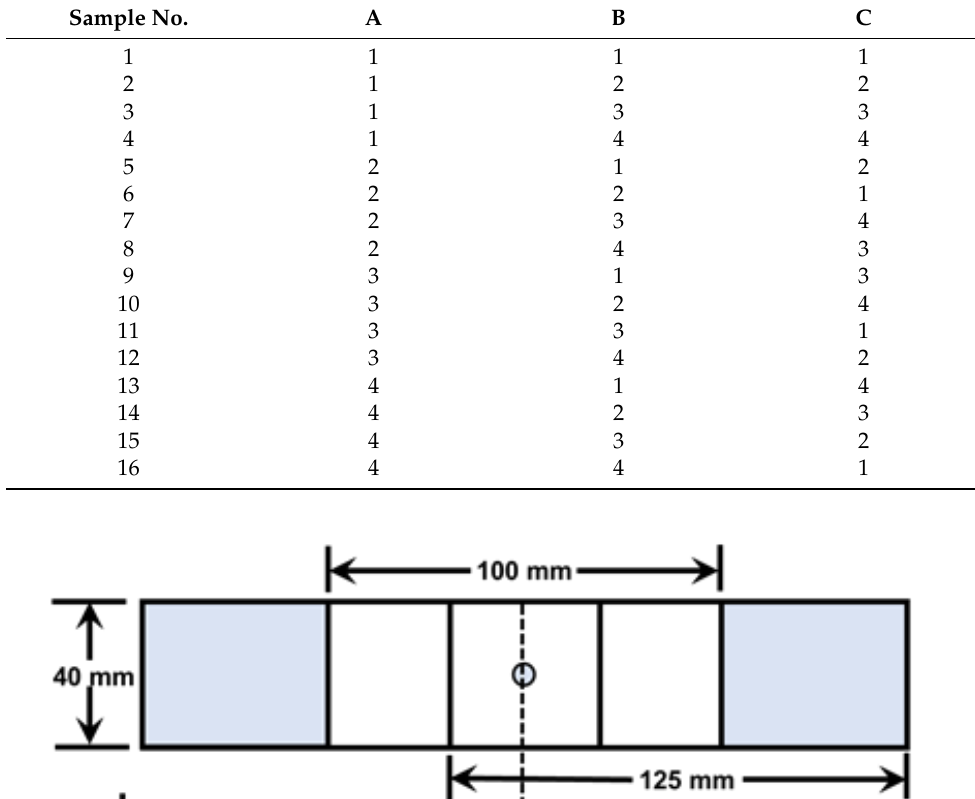
Table 4. Taguchi L16 (OA) for experimental design of DPW scheme. Sample No.